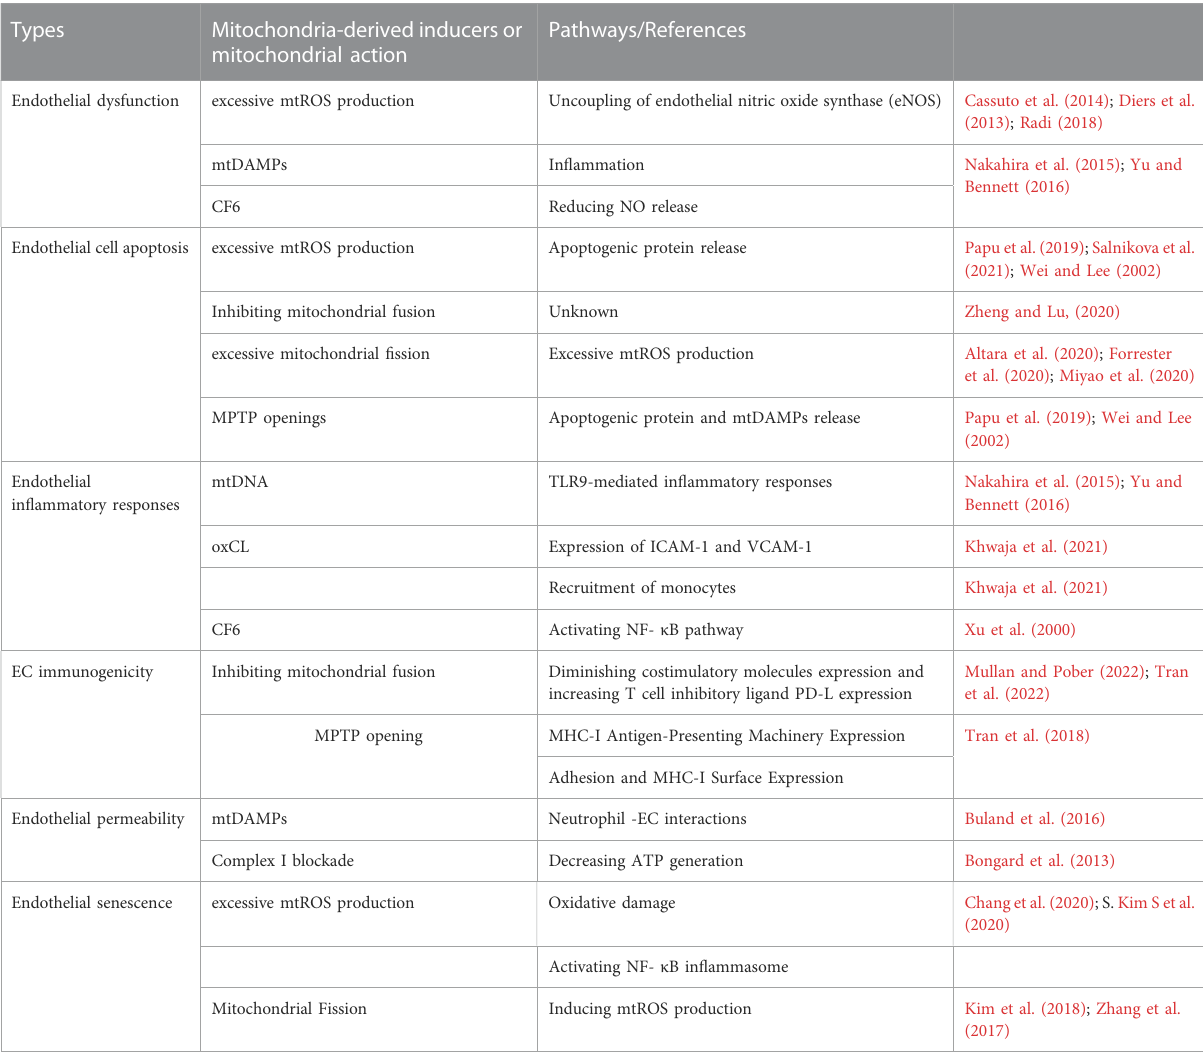
TABLE 2 Mitochondria-mediated endothelium